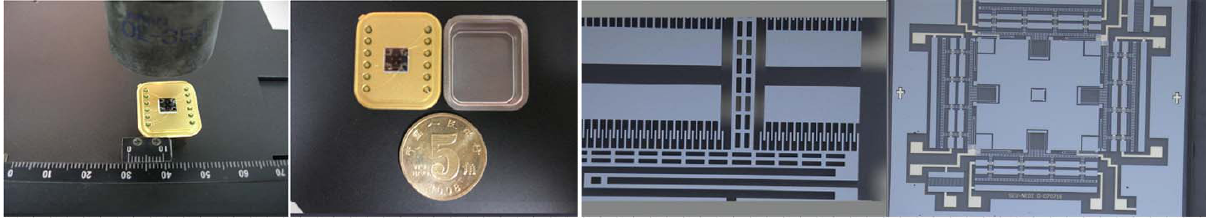
Figure 2. The package and SEM photos of a SMG